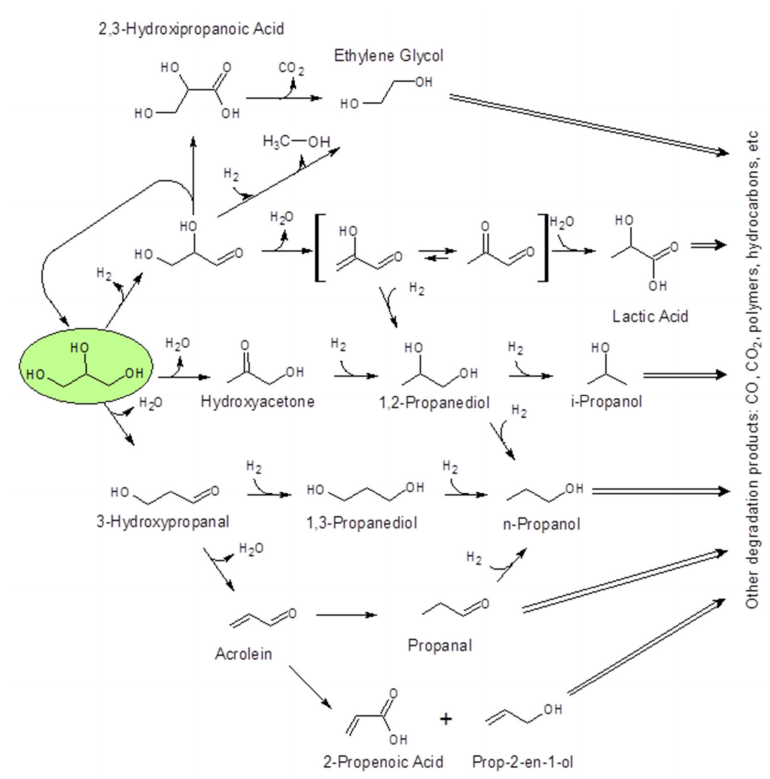
Figure 8. Di ff erent main products observed in glycerol (green) hydrogenolysis.